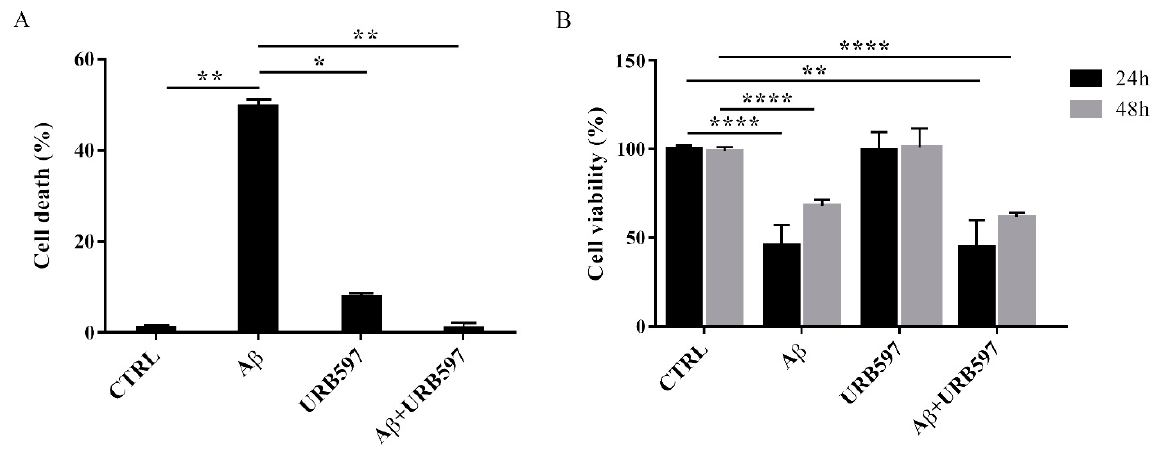
Figure 2. Effects of A β 25–35 in the presence or absence of URB597 on BV-2 cells. ( A ) Trypan blue exclusion test. Cell count was determined in BV-2 cells exposed for 24 h to 30 µ M of A β 25–35 in the presence or absence of 5 µ M of URB597 and expressed as cell death (cell death/cell death + living cell). Data are reported as percentage versus CTRL. ( B ) Analysis of cell viability was evaluated by MTT assay. MTT reduction was analyzed in the same samples of treated cells at 24 h and 48 h. Data are expressed as percentage versus CTRL. The values are the mean ± SEM of triplicate determination from independent experiments. * p < 0.05, ** p < 0.01, **** p < 0.0001.